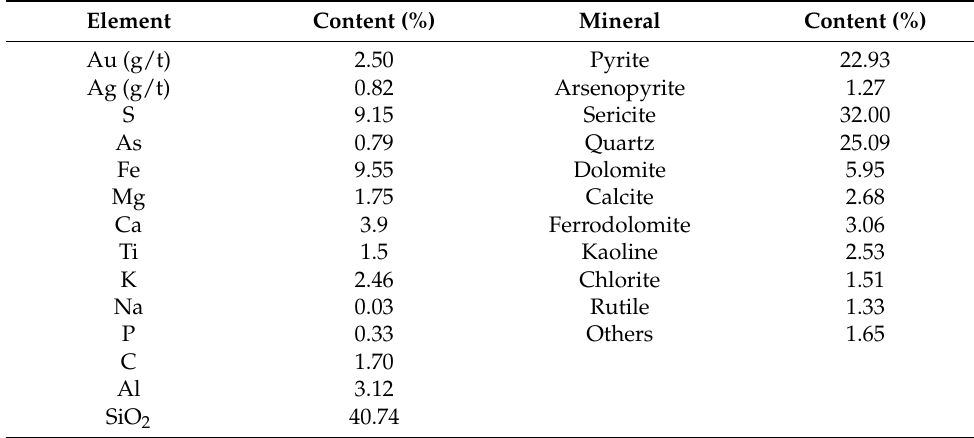
Table 1. The main elements of the Carlin-Type gold